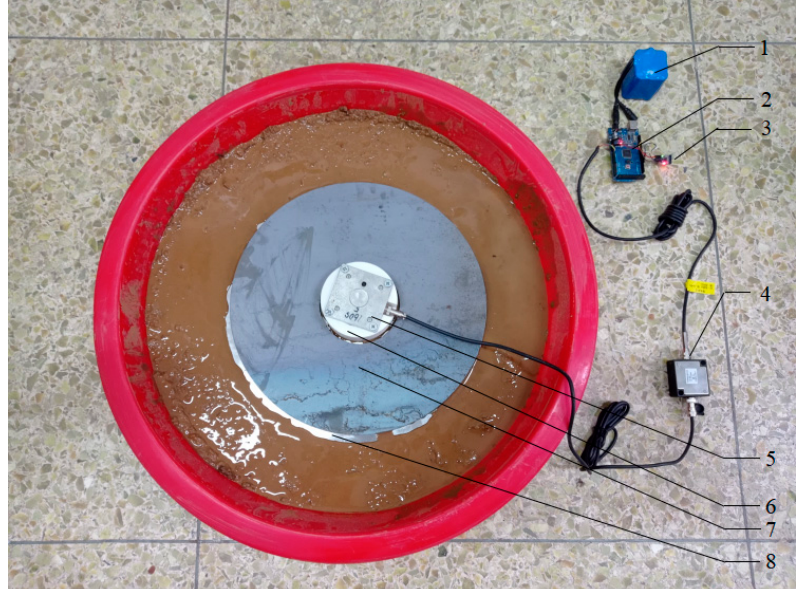
Figure 7. Ground pressure calibration device. 1. 12 V power supply. 2. Arduino controller. 3. Wireless serial port transceiver module. 4. Signal amplifier. 5. Pressure sensor. 6. Mounting base. 7. Counterweight plate. 8. Bottom plate.